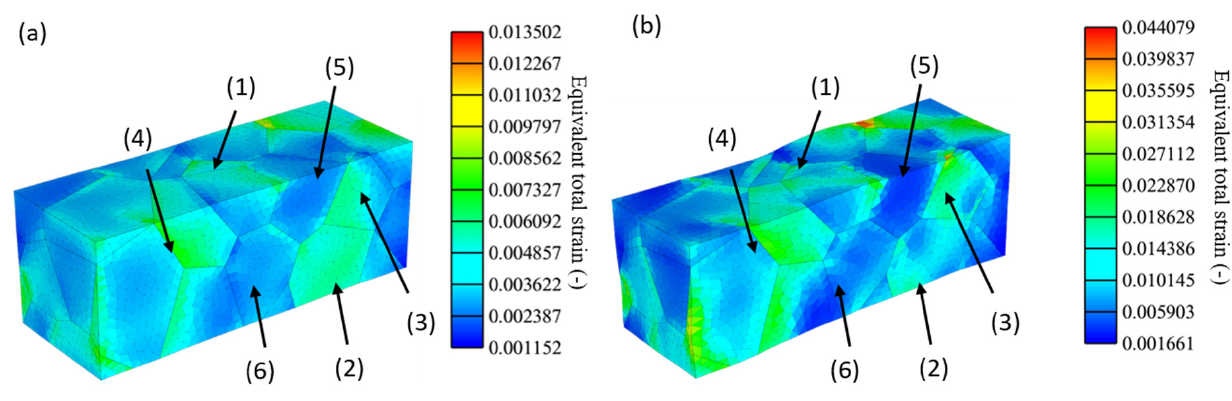
Figure 12. Equivalent total strain for ( a ) 0.4% global applied total strain and ( b ) 1% global applied total